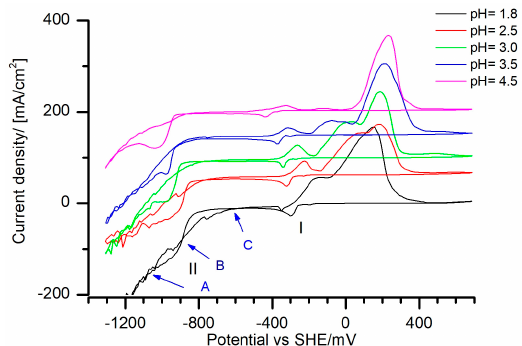
Figure 3. CVs in the Fe(III)–Sn(II) electrolytes (both Fe and Sn 0.11 M) recorded at different pH values. The cathode was polarized first until − 1303 mV and then until − 703 mV vs. standard hydrogen electrode (SHE) with the scan rate of 50 mV/s.